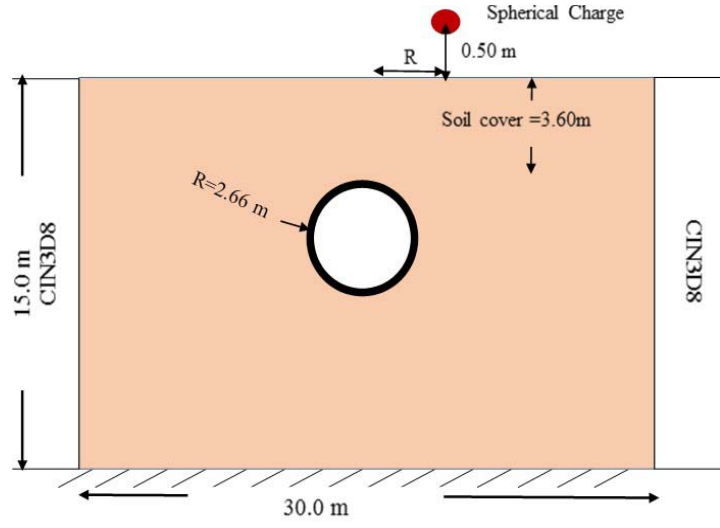
Figure 1 : Soil and tunnel